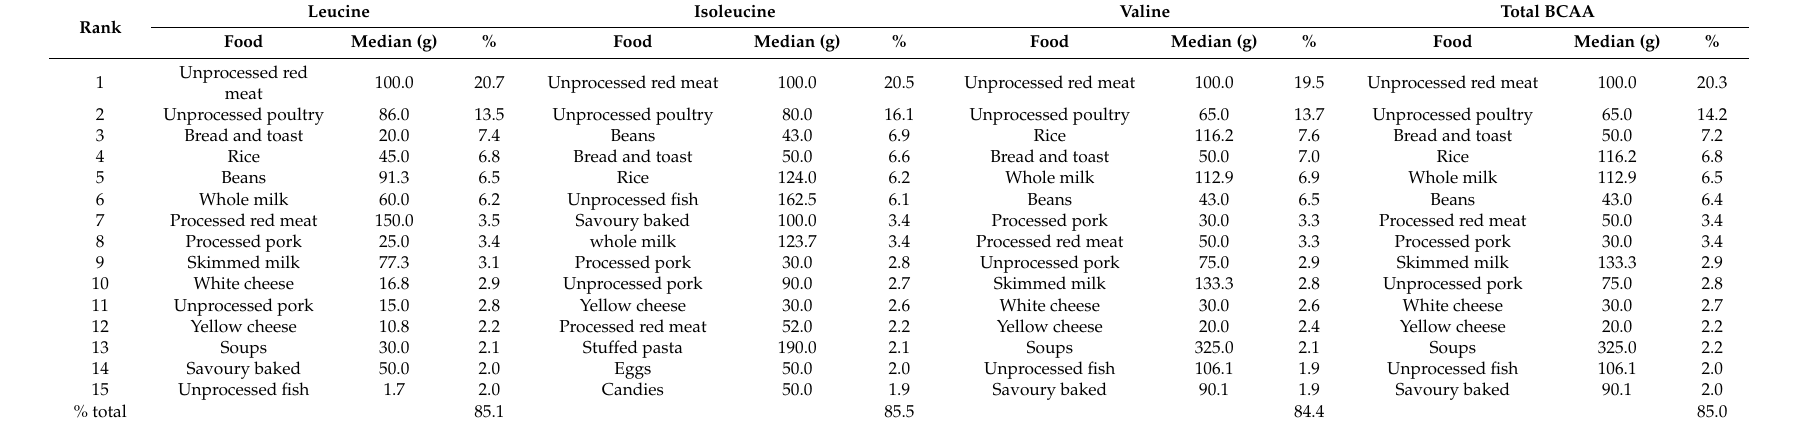
Table 6. Main food contributors to dietary intake of branched chain amino acids in older adults, ISA Capital, S ã o Paulo, Brazil,